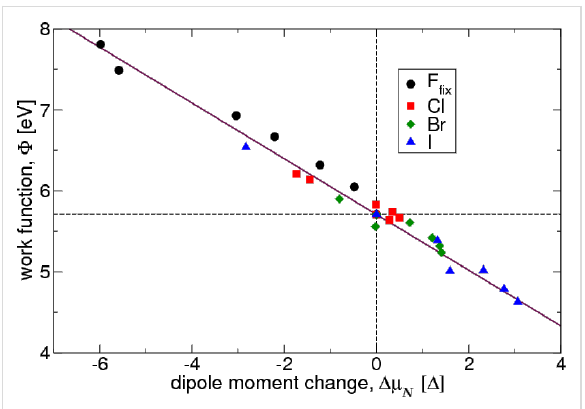
Figure 4: Calculated work function versus dipole moment. The solid line corresponds to the expectation according to Equation 1.